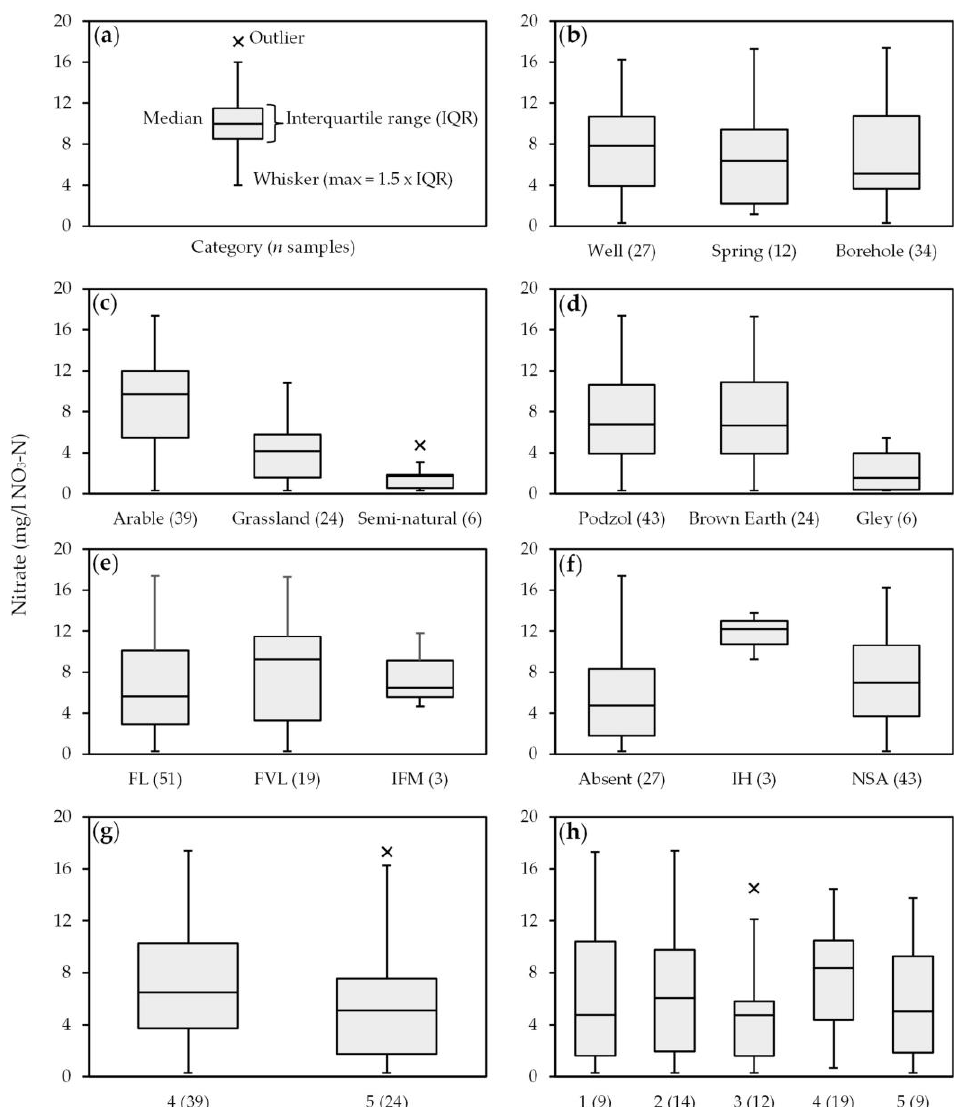
Figure 4. Box plots of groundwater sample nitrate concentrations in the River Ythan catchment, classified by ( a ) annotated box plot example; ( b ) groundwater monitoring point construction details; ( c ) land use classification; ( d ) soil type; ( e ) BGS bedrock aquifer productivity categories (FL) fracture flow low productivity, (FVL) fracture flow very low productivity, (IFM) intergranular and fracture flow moderate productivity; ( f ) BGS superficial aquifer productivity (Absent) no superficial aquifer present, (IH) intergranular flow high productivity, (NSA) not a significant aquifer; ( g ) BGS ground- water vulnerability rating; and ( h ) DRASTIC groundwater vulnerability rating (1) very low risk, (2)